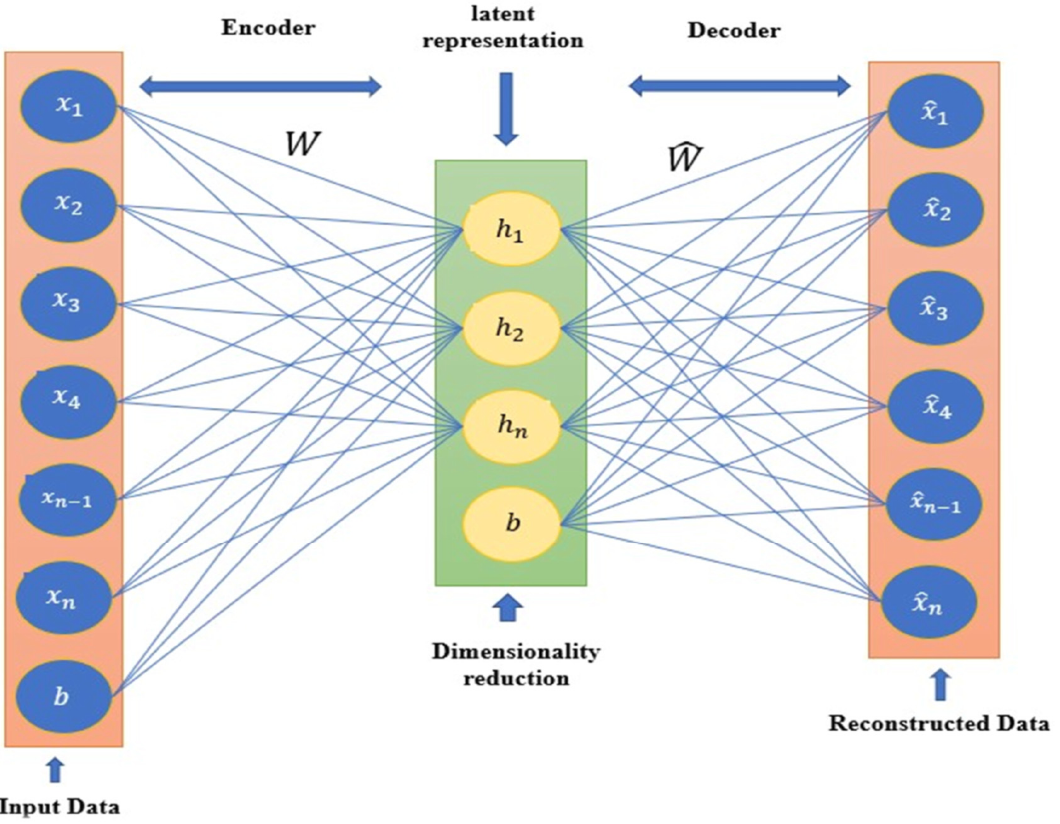
Figure 1. The Standard structure of Autoencoder.